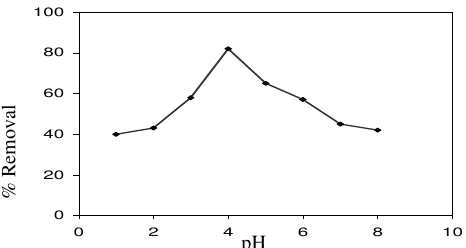
Figure 5 . Influence of P H on percent removal of fluoride on CCS.